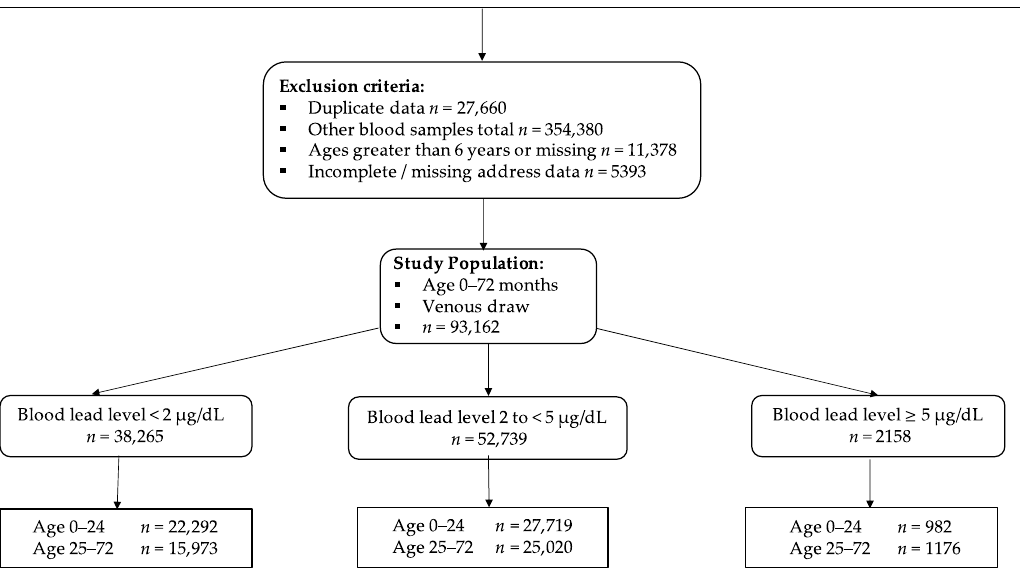
Figure 1. Study Schema for Georgia Department of Public Health Lead Prevention Program Surveillance Dataset from 2010 to 2018 for children aged 0–6 years old (0–72 months).